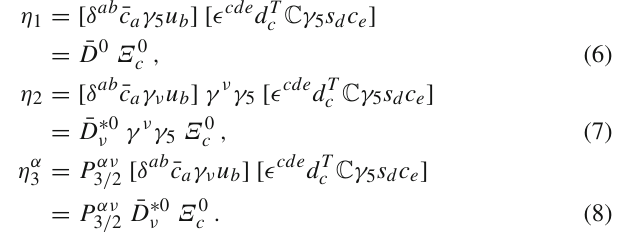
Ξ − → J /ψ K − Λ decays [3]. Its mass and width were b